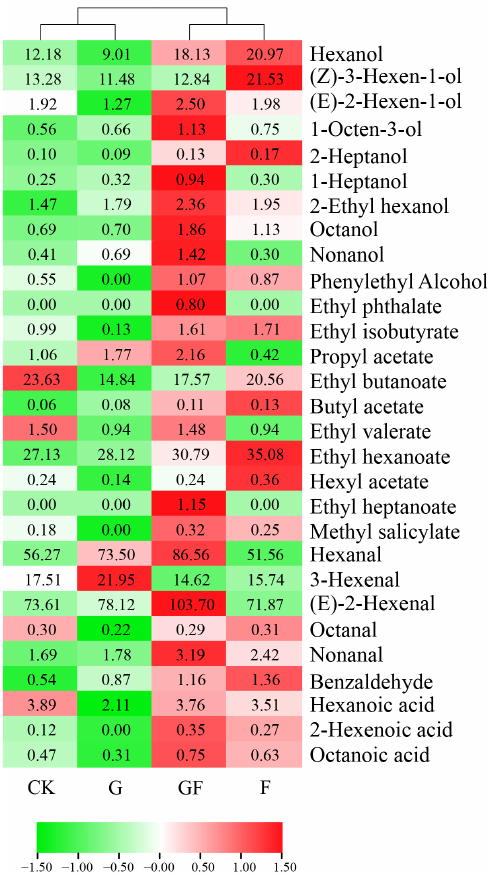
Figure 4. Concentrations (µg/L) of volatile compounds determined under girdling and foliar fertilization with K treatments in the pulp juice of ‘Hanxiangmi’ table grape at harvest. Table 1. Concentrations (µg/L) of terpene compounds determined under girdling and foliar fertilization with K treatments in the pulp juice of ‘Hanxiangmi’ table grape during berry development. N.D: not detected. Different letters within the same row indicate significant differences at p < 0.05.